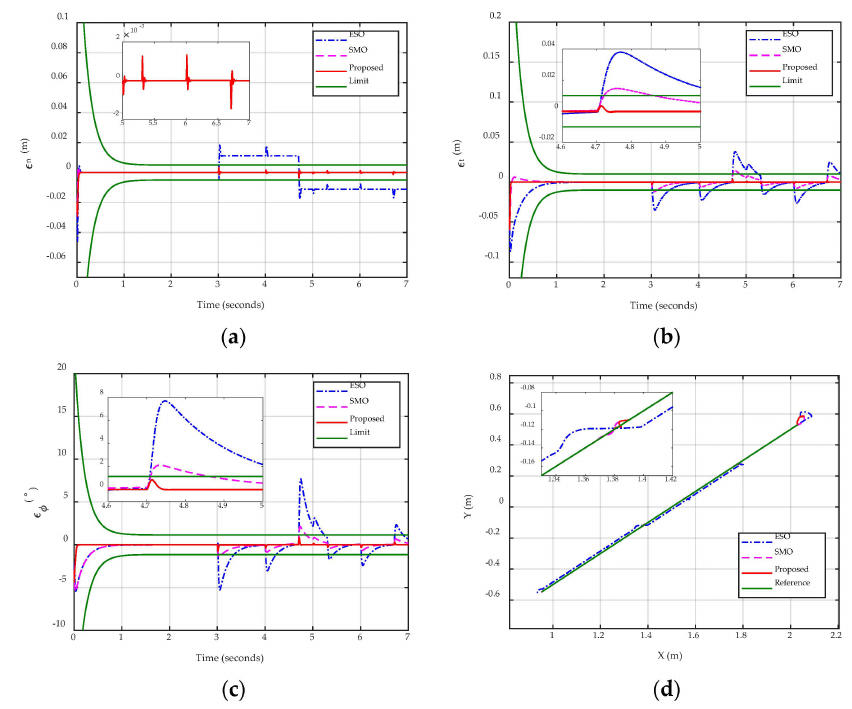
Figure 9. Control performance in terms of ( a ) contouring error, ( b ) tangential error, ( c ) orientation error, and ( d ) contour shape in Case 2.